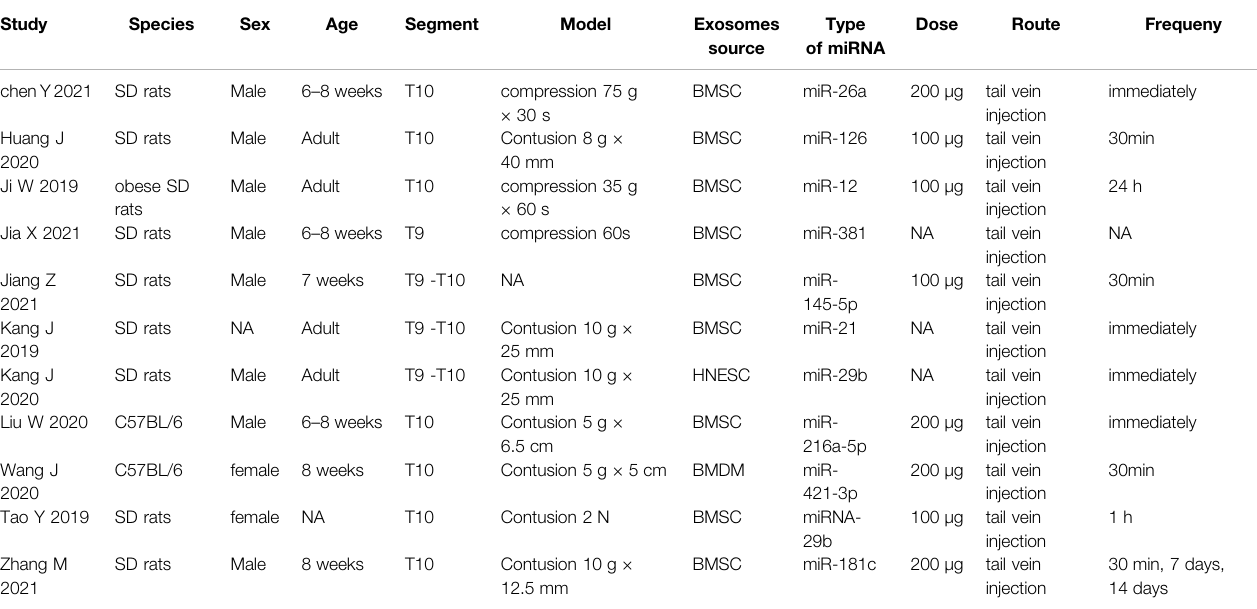
TABLE 1 | Summary of included studies.